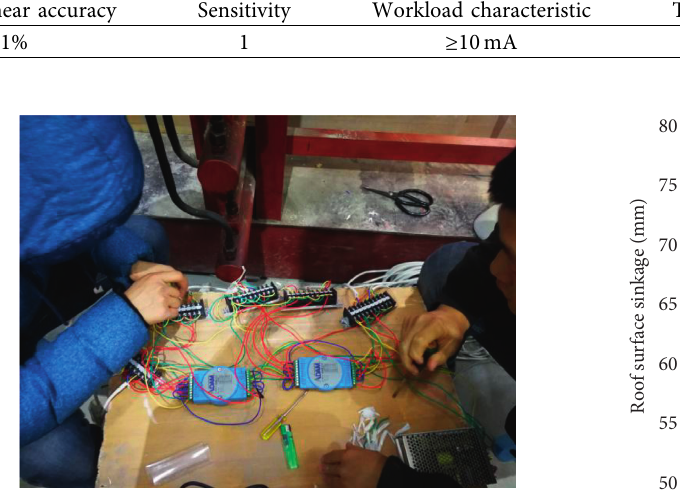
Figure 10: Experimental data test acquisition system.